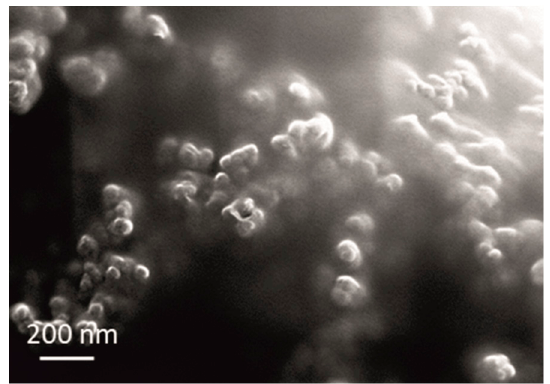
Figure 4. SEM micrograph of the used commercial CeO 2 powder.